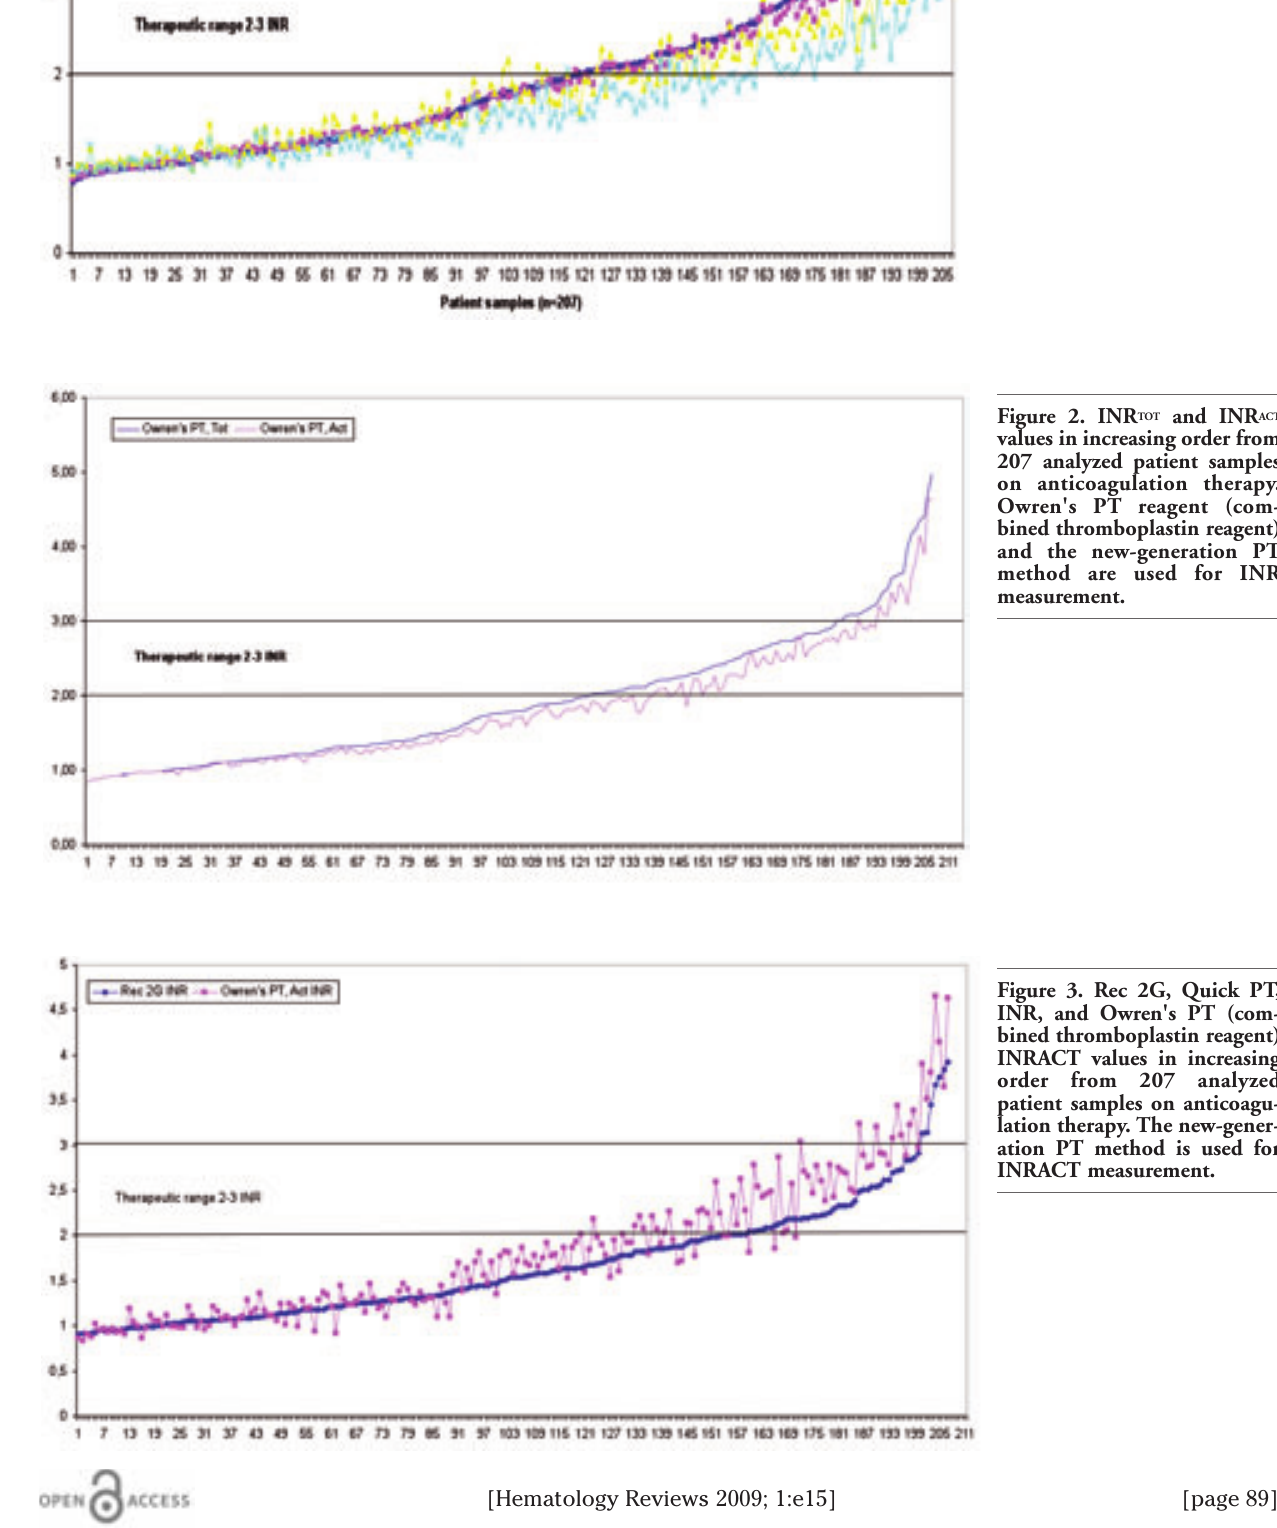
Figure 1. INR values in increasing order from 207 ana- lyzed patient samples on anti- coagulation therapy. Nycotest PT and Owren's PT are Owren methods (combined thrombo- plastin reagent), and PT- FibHS and Rec 2G are Quick methods.